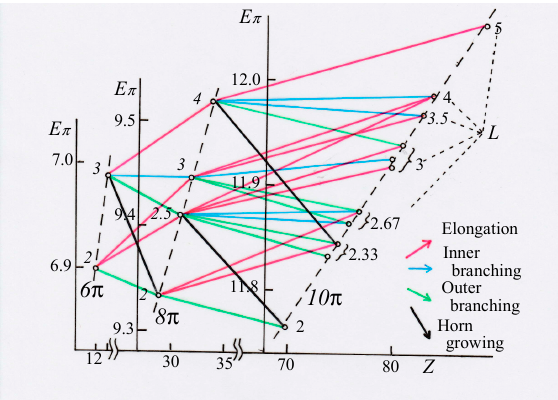
Figure 7. Quantitative diagram demonstrating the systematic growing scheme of the genealogy of C 6 ~C 10 isomers.